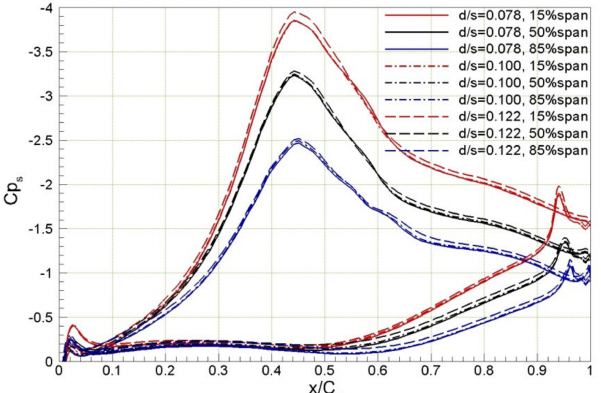
Figure 12. Distribution of the time-averaged static pressure coefficient on the integrated LPT-GV in the